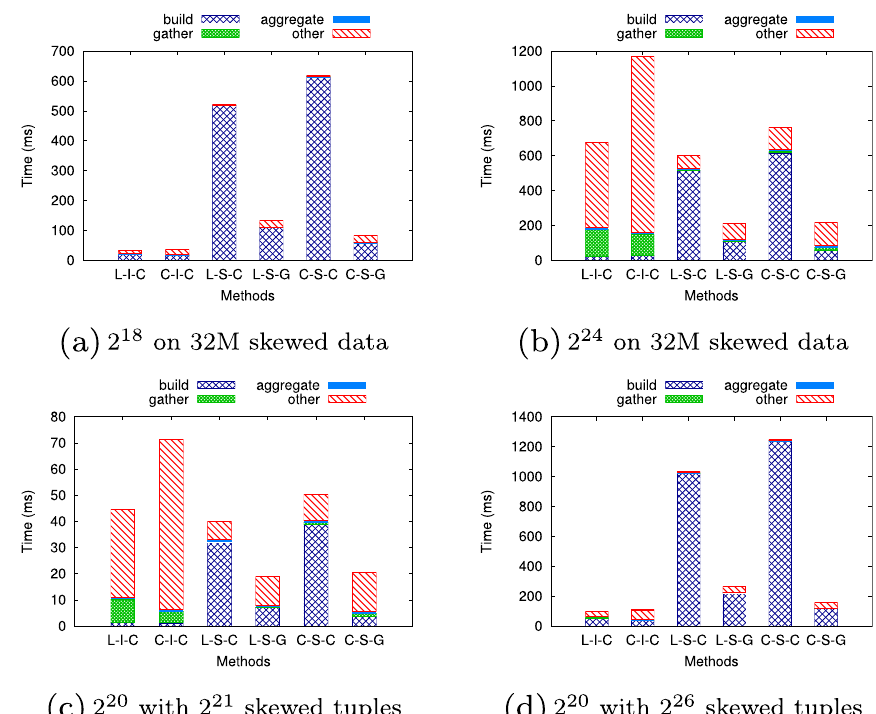
Fig. 14 Time breakdown in four cases on the skewed data